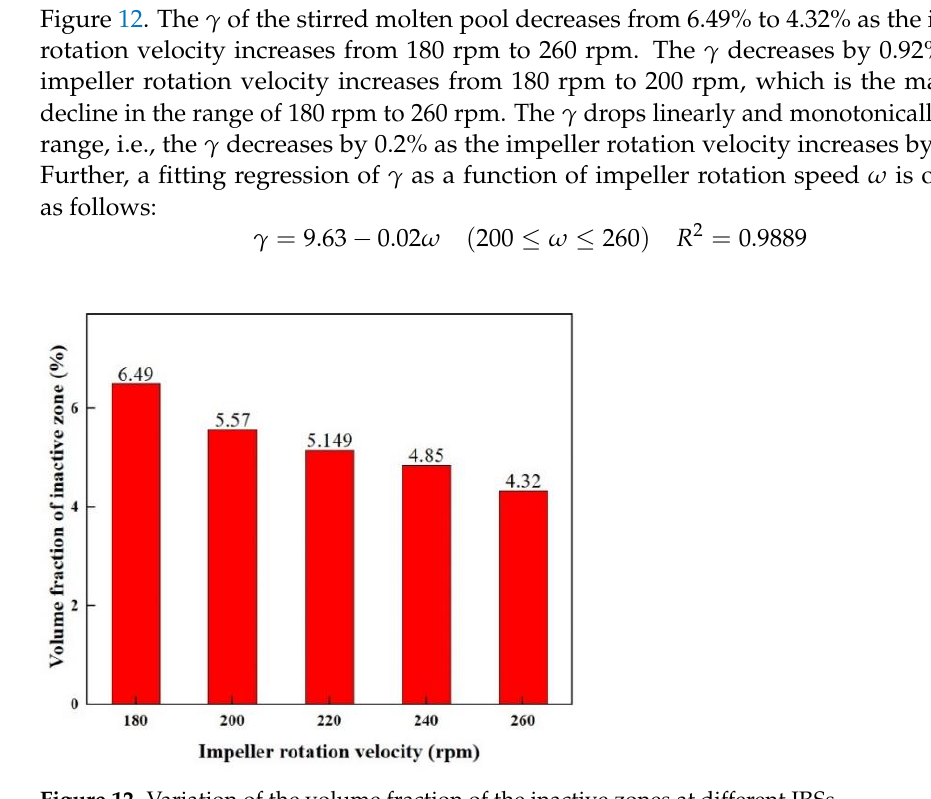
Figure 11. Comparison of the volume fraction of inactive zones at different IIDs.